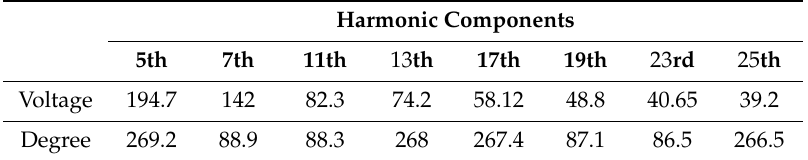
Table 6. Harmonic components of the rotor voltage for test case 2.